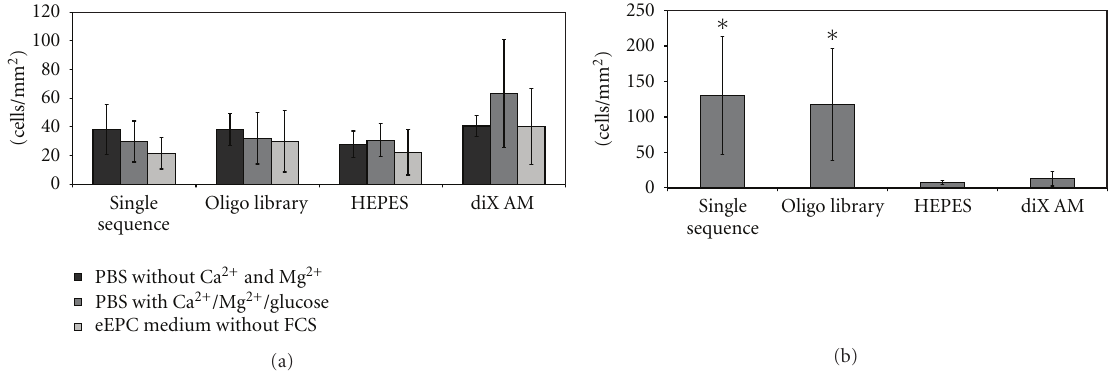
Figure 7: Influence of FCS on cell adhesion on oligonucleotide coated diX AM surfaces. (a) Samples were incubated with 0,05 ∗ 10 6 eEPC cells for 2,5 h under dynamic conditions in medium or bu ff er without FCS. Cell number was counted in microscopy images ( n = 6). ANOVA tests revealed no significant di ff erence between the groups. (b) Samples were preincubated with eEPC Medium containing FCS for 2 h. Afterwards 0,05 ∗ 10 6 eEPC cells were applied for 2,5h under dynamic conditions in medium without FCS. Cell number was counted in microscopy images ( n = 6). Groups marked with ∗ are significantly di ff erent to HEPES and diX AM samples ( P < 0 . 05).